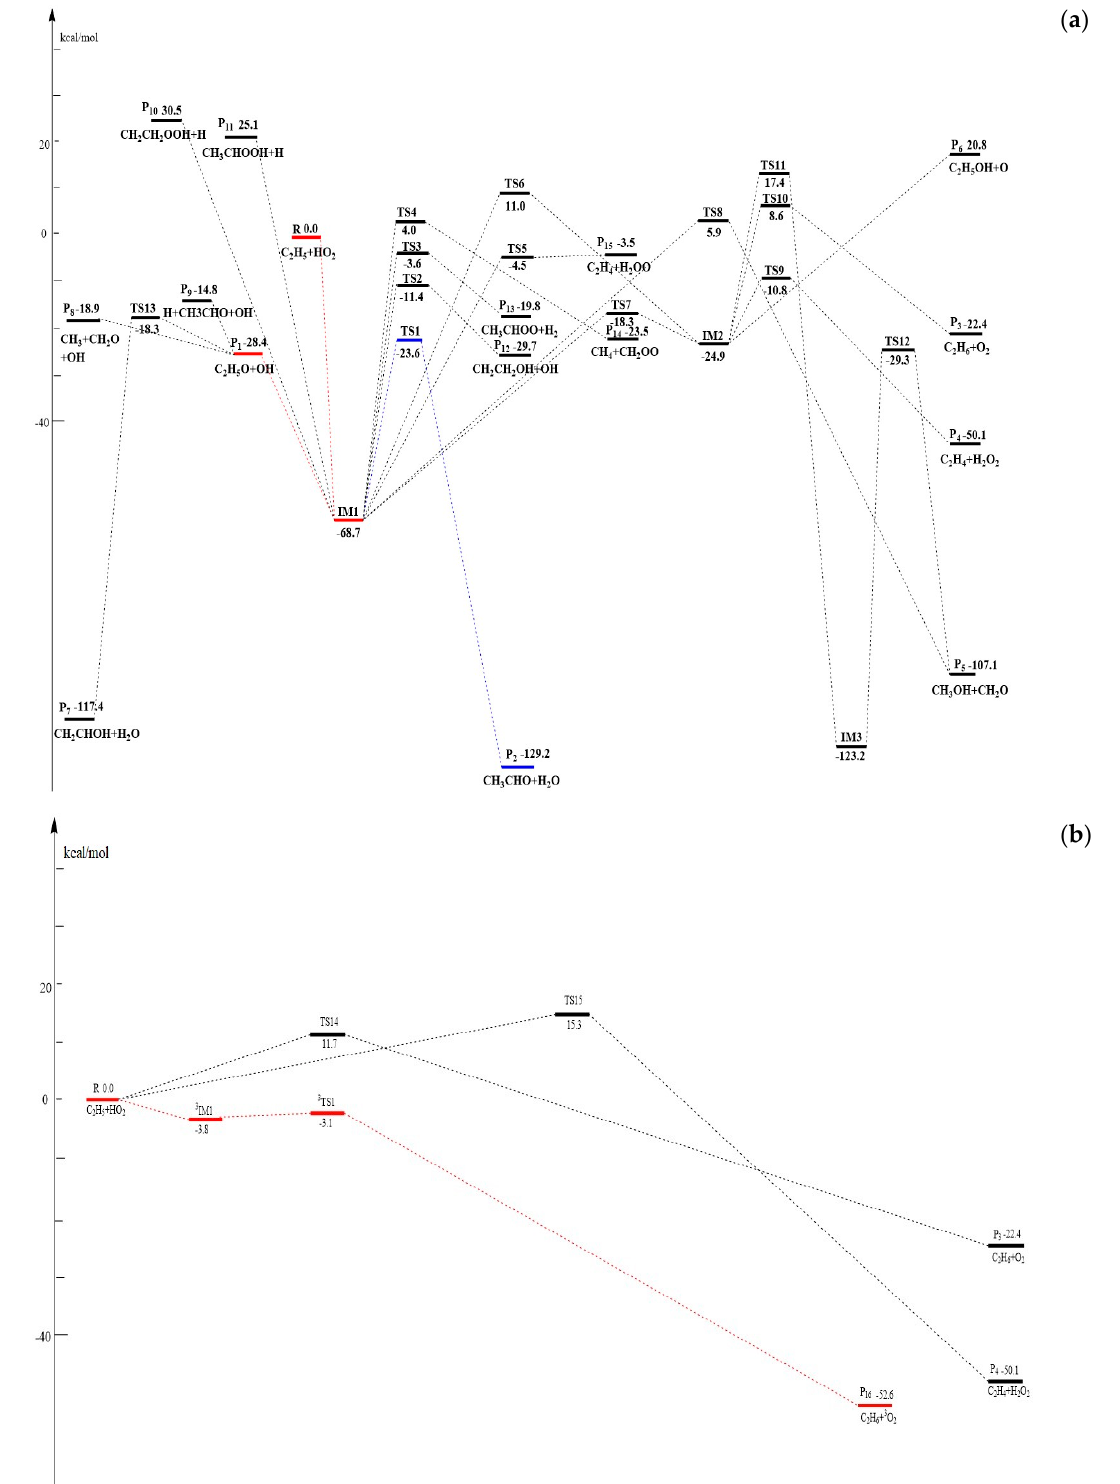
Figure 2. ( a ) Schematic singlet potential energy surface (PES) of the addition and dissociation reaction channels for the C 2 H 5 + HO 2 reaction at the CCSD(T)/6-311+G(3df,2p)//MP2/6-311++G(d,p)+ZPE level. ( b ) Schematic singlet and triplet PESs of the abstraction reaction channels for the C 2 H 5 + HO 2 reaction at the CCSD(T)/6-311+G(3df,2p)//MP2/6-311++G(d,p)+ZPE level.